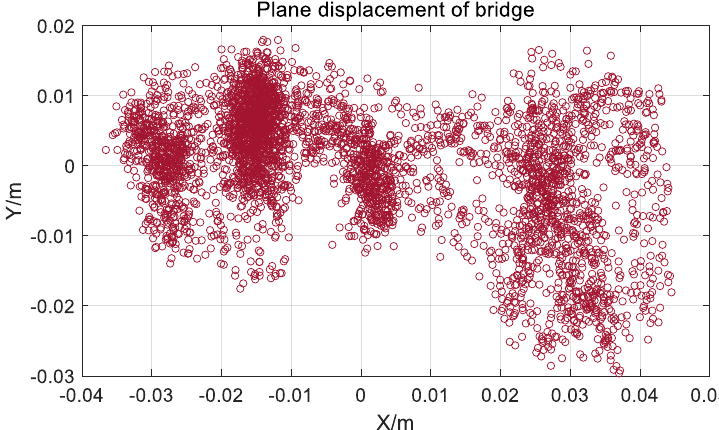
Figure 19. Plane displacement after coordinate transformation of Jiangyin Bridge.